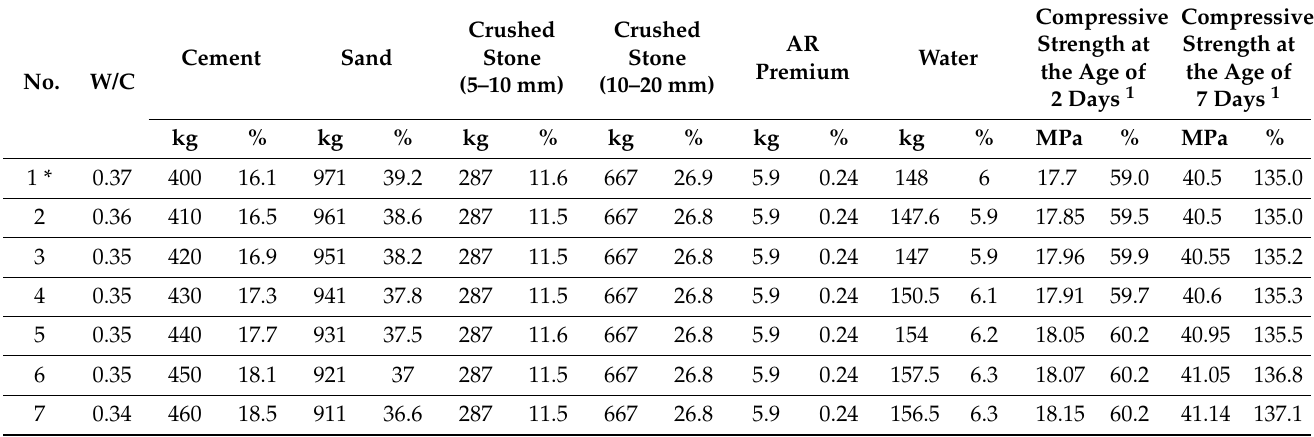
Table 14. Composition of RHC per 1 m 3 with an increased amount of cement.